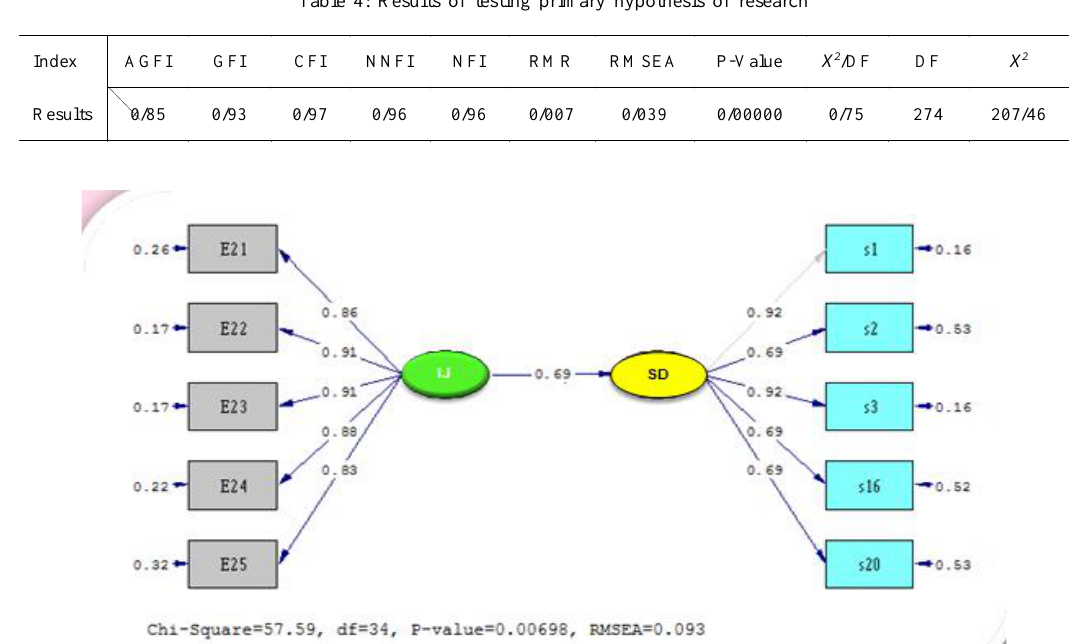
Table 4: Results of testing primary hypothesis of research